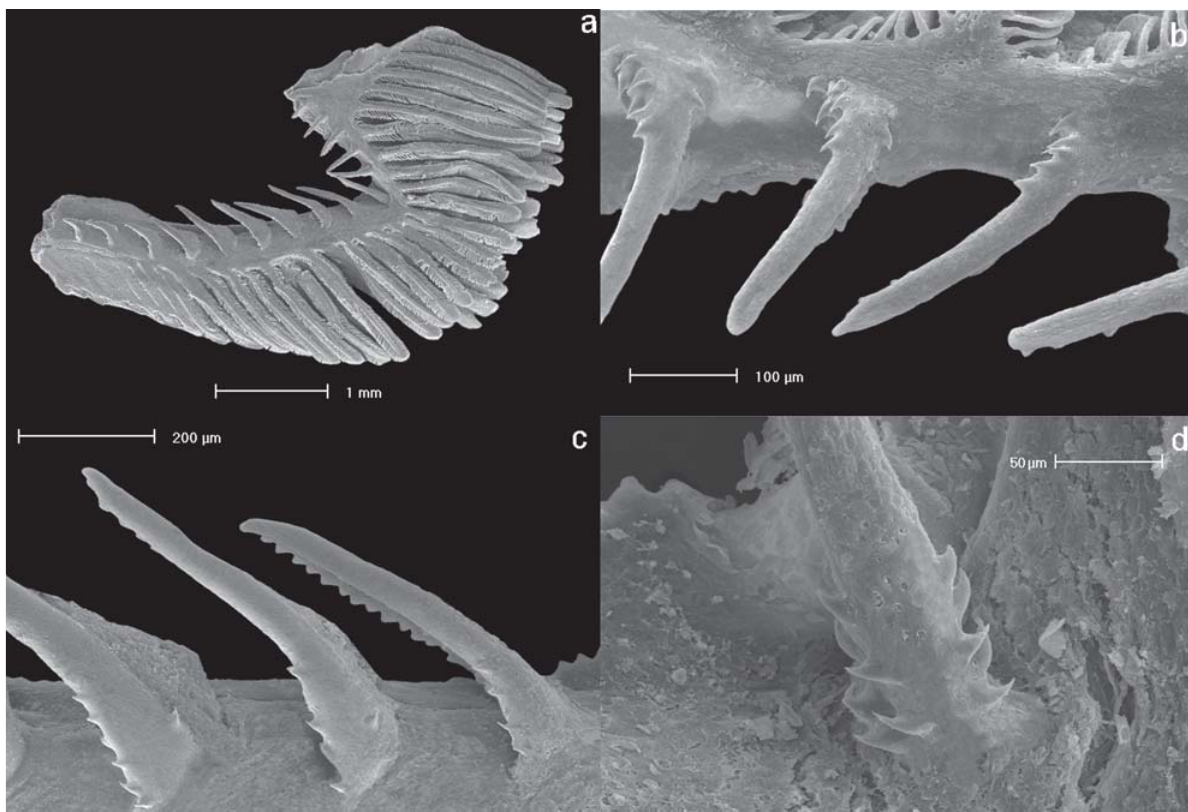
Fig. 16. First gill arch of Odontostilbe ecuadorensis , FMNH 113514, male 40.6 mm SL (photos a, b, d). SEM photographs of the left side gill arch showing gill gland (a), in detail gill rakers on upper branchial branch (b), gill rakers on lower branchial branch (FMNH 113513, unsexed 32.5 mm SL) (c), and the posteriormost gill raker on the lower branch in detail (d). Lateral view.